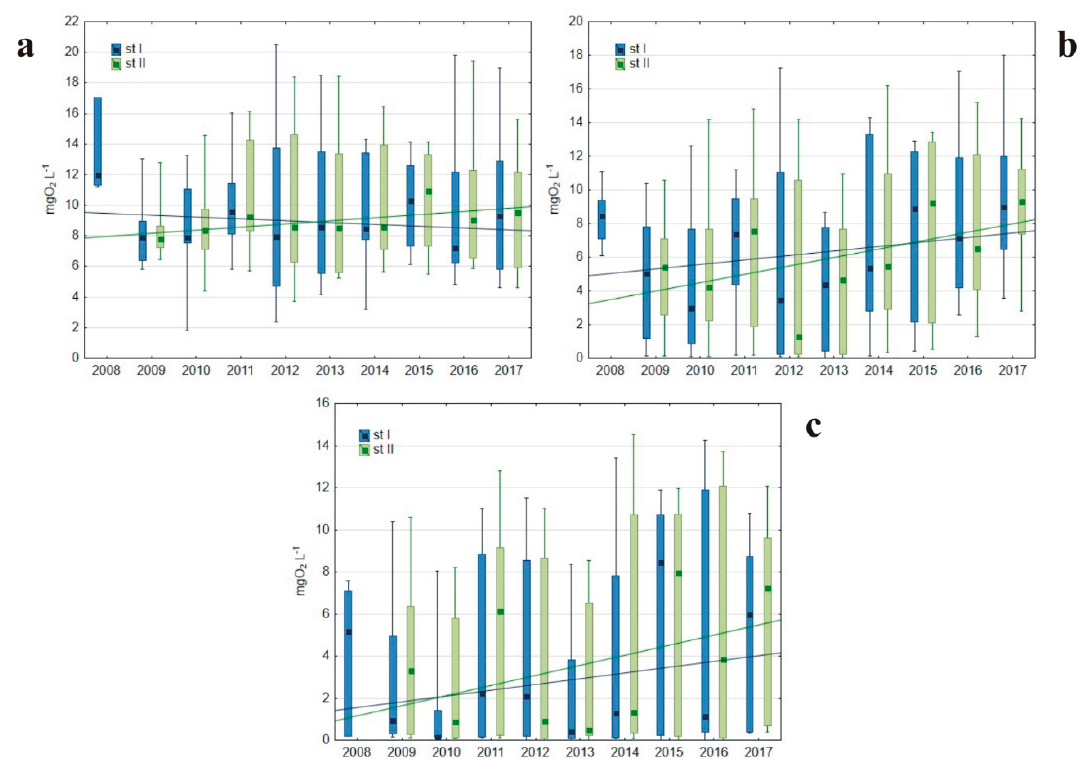
Figure 3. Box plot with min-max concentrations of oxygen in selected water layers at both stations representing: epilimnion ( a ); metalimnion ( b ); and hypolimnion ( c ). The lines indicate trendlines for each station.